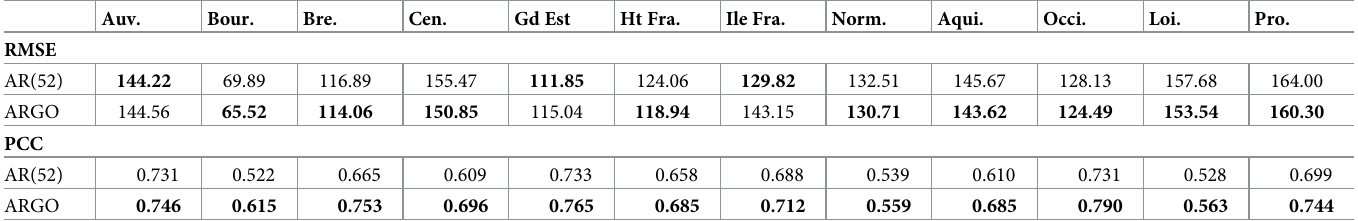
Table 9. Two-week ahead estimate—RMSE and PCC for ARGO models including only historical data (AR(52)) and only Twitter data, for the period starting from January 2015 to March 2017. Auv. Bour. Bre. Cen. Ht Fra.